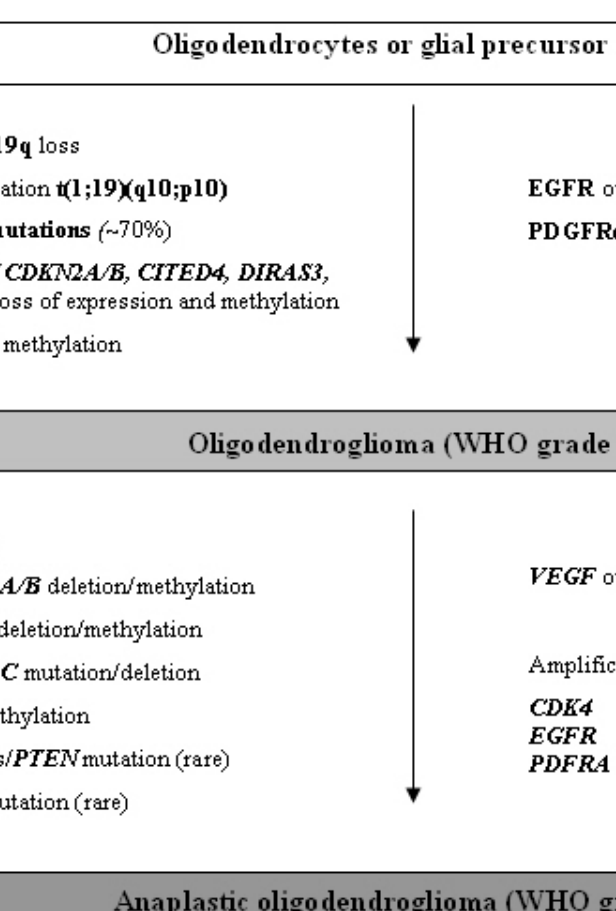
Figure 3. Schematic representation of the molecular pathogenesis and progression of